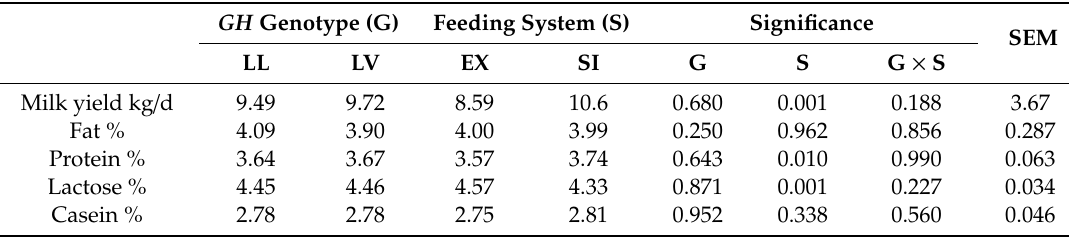
Table 2. E ff ects of growth hormone ( GH ) p.L127V genotype and feeding system on milk yield and composition in the Modicana